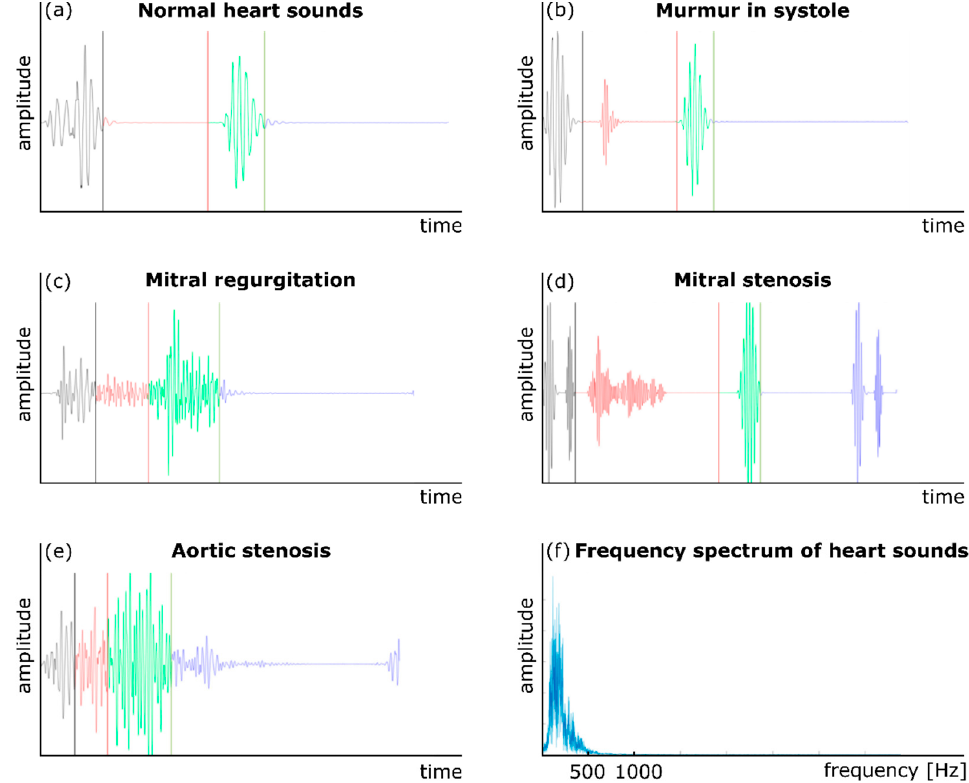
Figure 2. Normal and abnormal heart sounds: ( a ) a normal heart sound, ( b ) murmur in the systole, ( c ) mitral regurgitation, ( d ) mitral stenosis, ( e ) aortic stenosis, and ( f ) the frequency content of a PCG signal. Adapted from ref. [10].